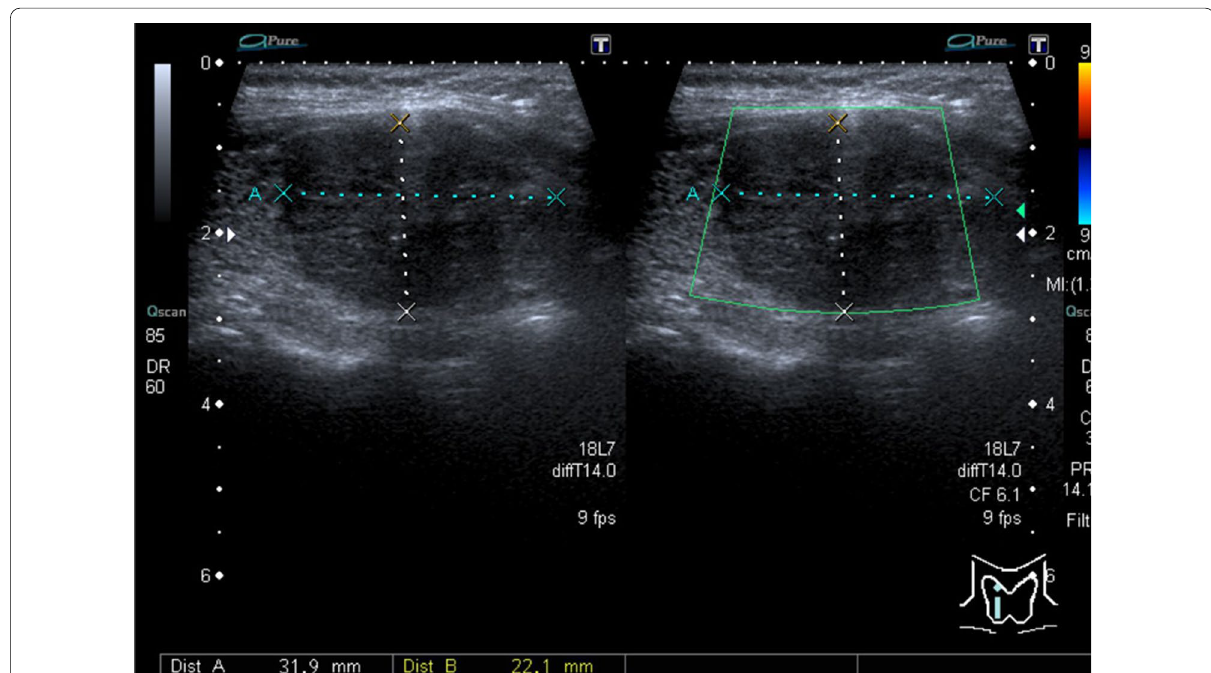
Fig. 3 Male euthyroid patient, 34-years old. Right thyroid lobe longitudinal view; gray-scale (right) and Doppler (left) U/S shows hypoechoic nodules proved to be papillary carcinoma